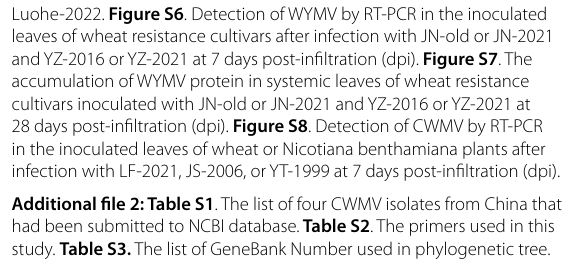
Additional file 2: Table S1 . The list of four CWMV isolates from China that had been submitted to NCBI database. Table S2 . The primers used in this study. Table S3. The list of GeneBank Number used in phylogenetic